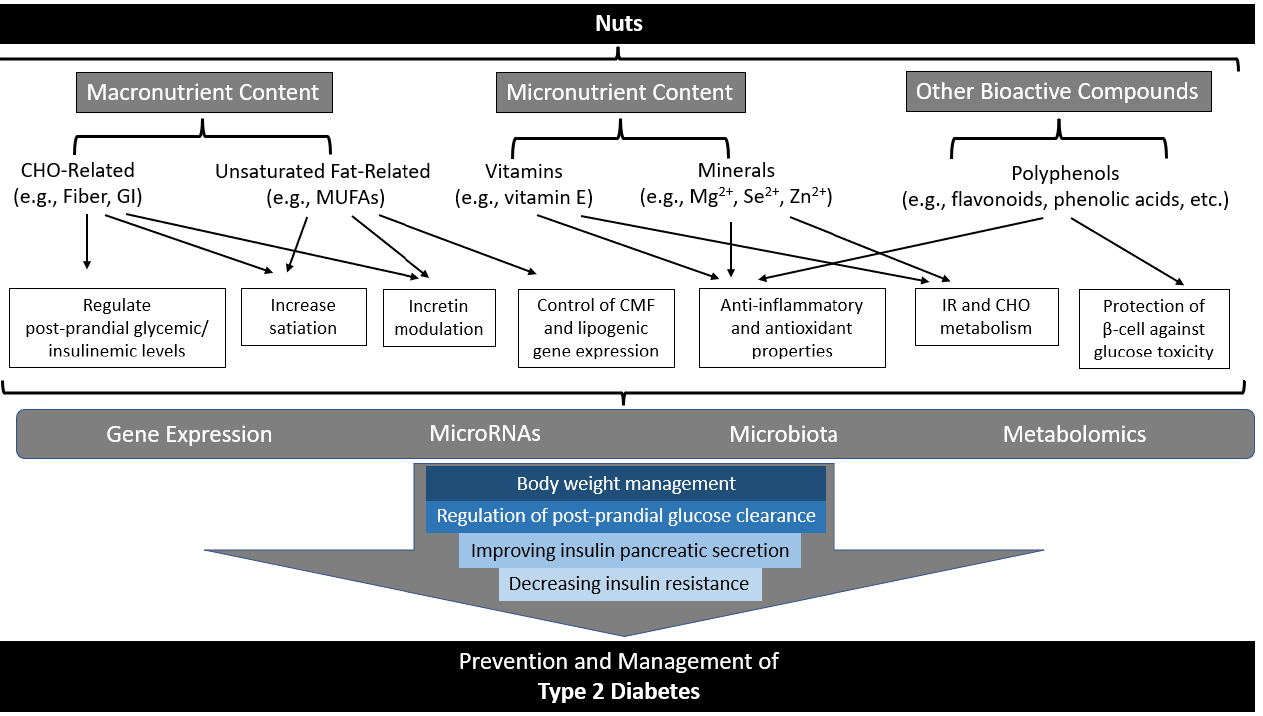
Figure 1. Summary of potential mechanisms of action for the role nuts may play in diabetes prevention and management. Adapted with permission from Ref. [60]. 2017, Hernández-Alonso et al. Abbreviations: CHO, carbohydrate; CMF, cellular membrane fluidity; GI, glycemic index; IR, insulin resistance; MUFAs, monounsaturated fatty acids; RNA, ribonucleic acid.